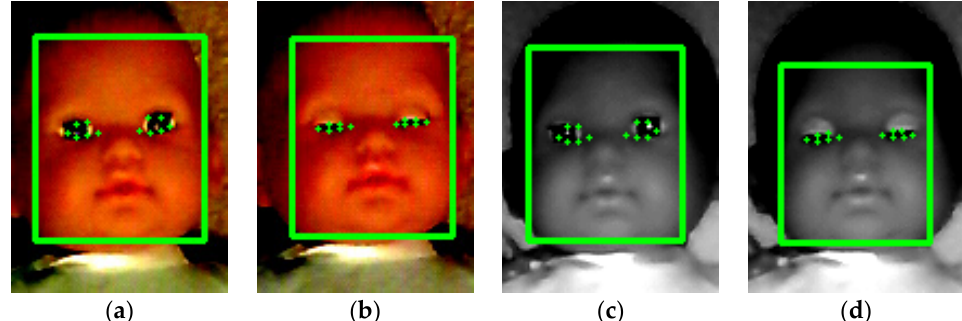
Figure 12. Face and eye landmark detection: ( a ) eye opened in day (EAR = 0.43); ( b ) eye closed in day (EAR = 0.17); ( c ) eye opened in night (EAR = 0.42); ( d ) eye closed in night (EAR = 0.19).